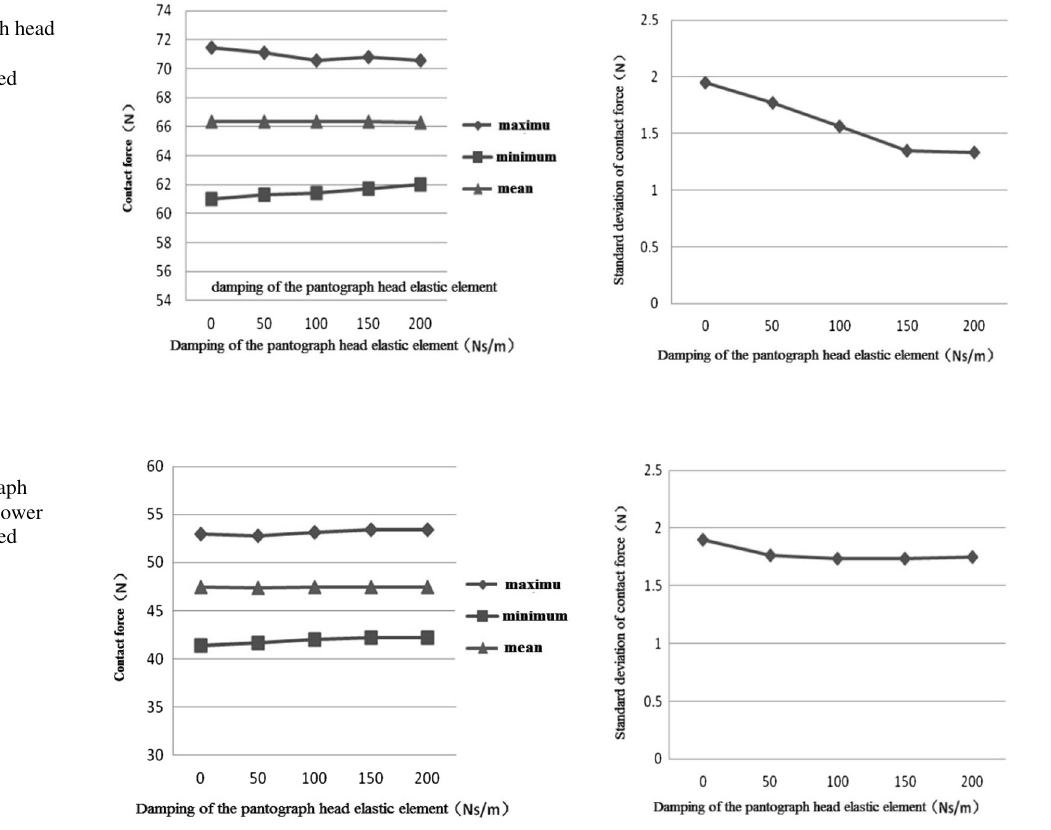
Fig. 13 The influence of damping of left pantograph head elastic element on power collection quality in curved track